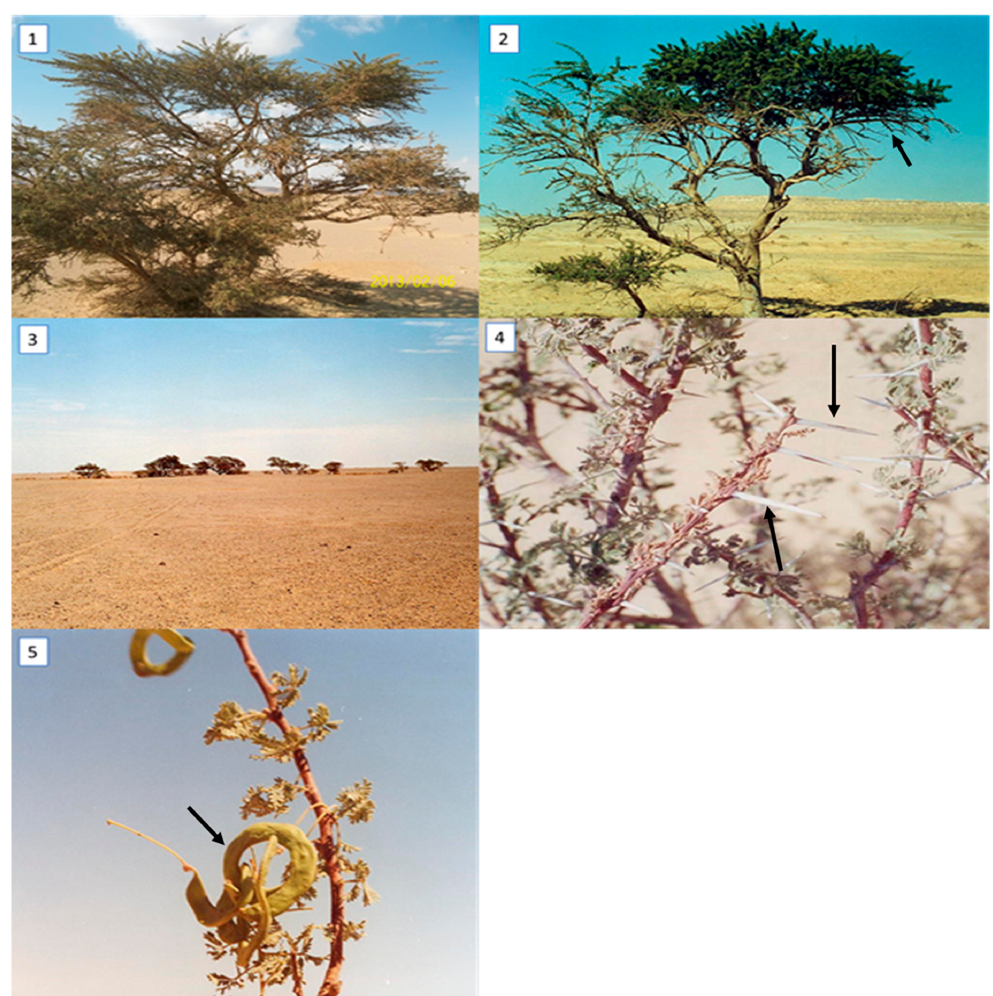
Figure 1. Morphological description of Acacia species growing in Egypt (1–5 ) Acacia tortilis ssp. raddiana (collected from Siwa Oasis, an urban oasis in Egypt between the Qattara Depression and the Great Sand Sea in the Western Desert nearly 50 km east of the Libyan border and 650 km from Cairo, 29°12 ′ 19N 25°31’10E 29°12´19N25°31´10E) . (1–3) showing the growth stage of Acacia under the desert conditions and (2, 4 and 5) arrows point to the different pine and pinna and show the difference in leaf length, pinna length and spine length. Photos were taken by Coauthor Nader R. Abdelsalam.